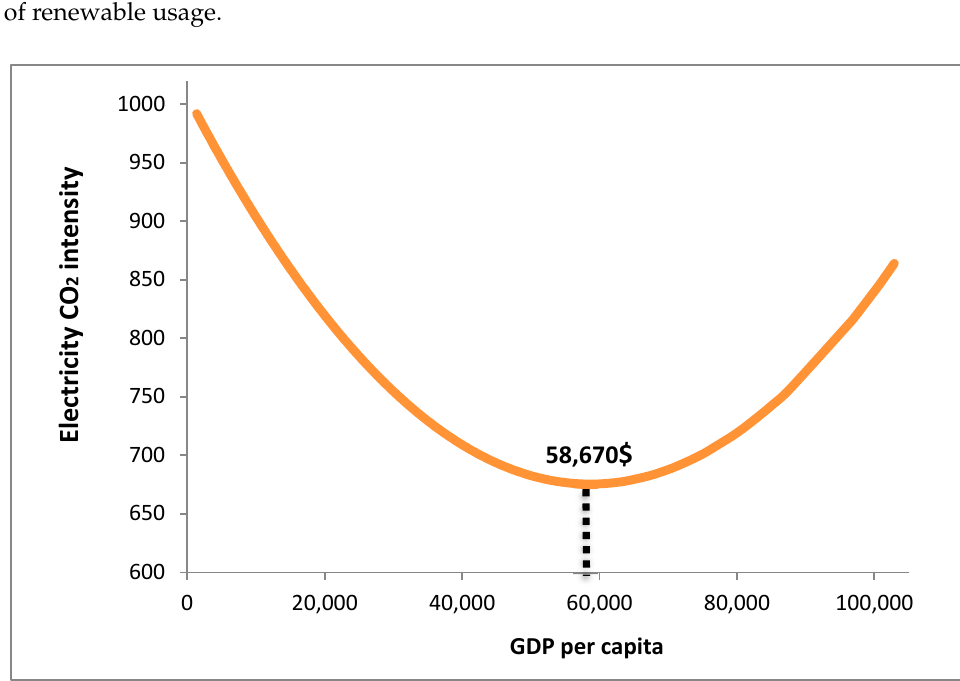
Figure 4. Electricity CO 2 intensity vs. polynomial function of Renewables usage. 5. Discussion and Policy Implications 5.1. GDP per Capita Based on the econometric outcomes presented in Section 4, it is evident that the re- lationship between electricity CO 2 intensity and GDP per capita is of a quadratic form, creating a U-shaped curve. As a result, the effect of the rising GDP per capita is found to decrease the power sector’s emitted CO 2 up to the turning point of 58,670 USD. Alt- hough seemingly unexpected, it must be taken into consideration that the present study